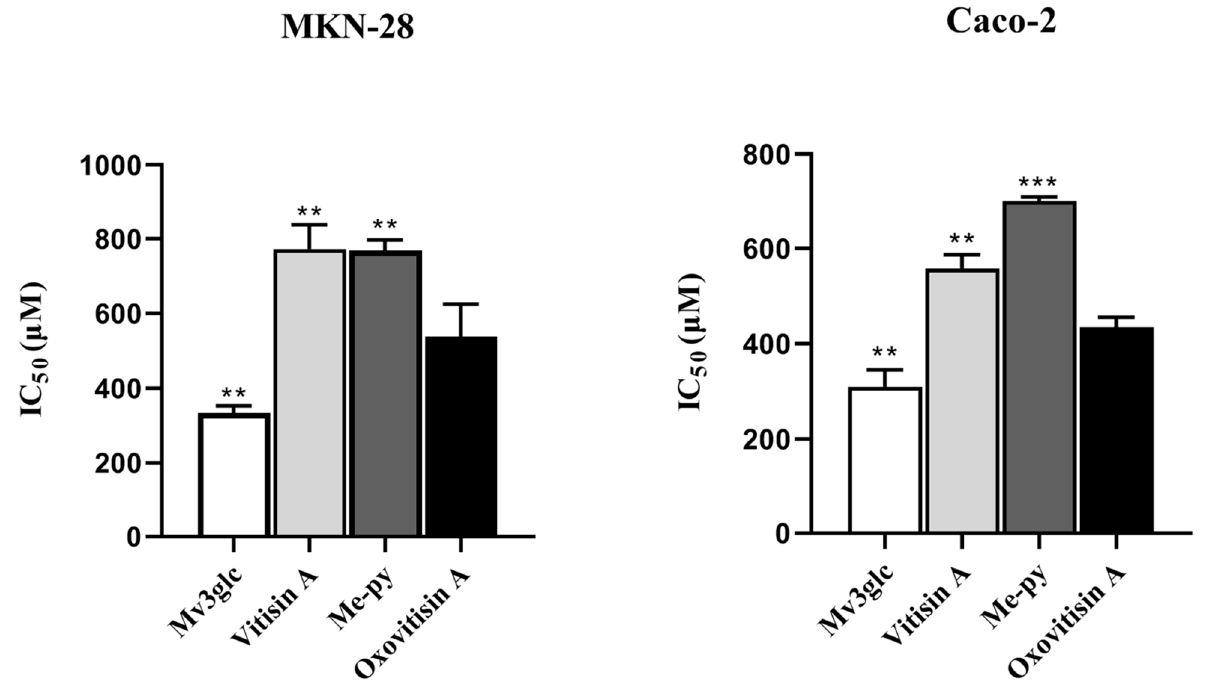
Figure 5. Antiproliferative abilities of Mv3glc, vitisin A, Me-py, and oxovitisin A against MKN-28 and Caco-2 cell lines in vitro. Each value represents the means ± SEM ( n = 6). ** p < 0.01, *** p < 0.001 vs. oxovitisin A.